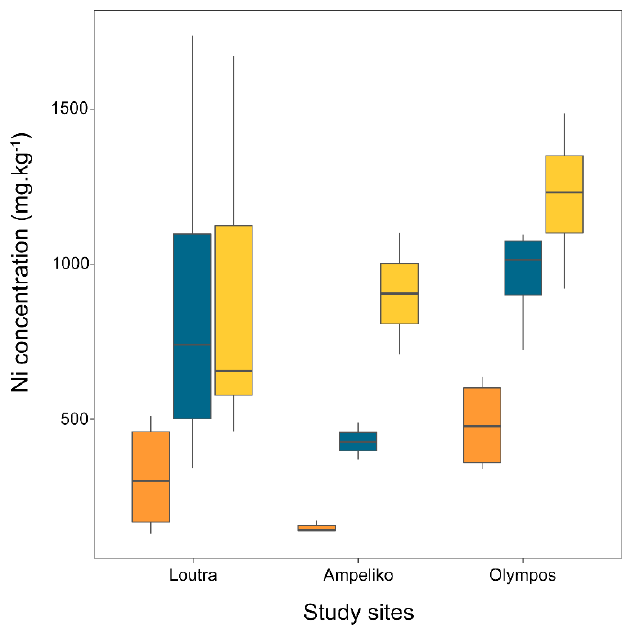
Figure 2. Ni concentration (mg.kg − 1 ) in different parts (flowers: orange boxplots; shoots: blue boxplots; tubercles: yellow boxplots) of Phelipanche nana individuals collected from three serpentine sites (Loutra, Ampeliko, Olympos) in the island of Lesbos, Greece. The central horizontal line in the box plots represents the median of the samples; the box plot edges represent the first and third quartile. The interquartile range (IQR) within the boxes present the central 50% of the values. The whiskers show the range of observed values and the locations of the minimum and the maximum values.